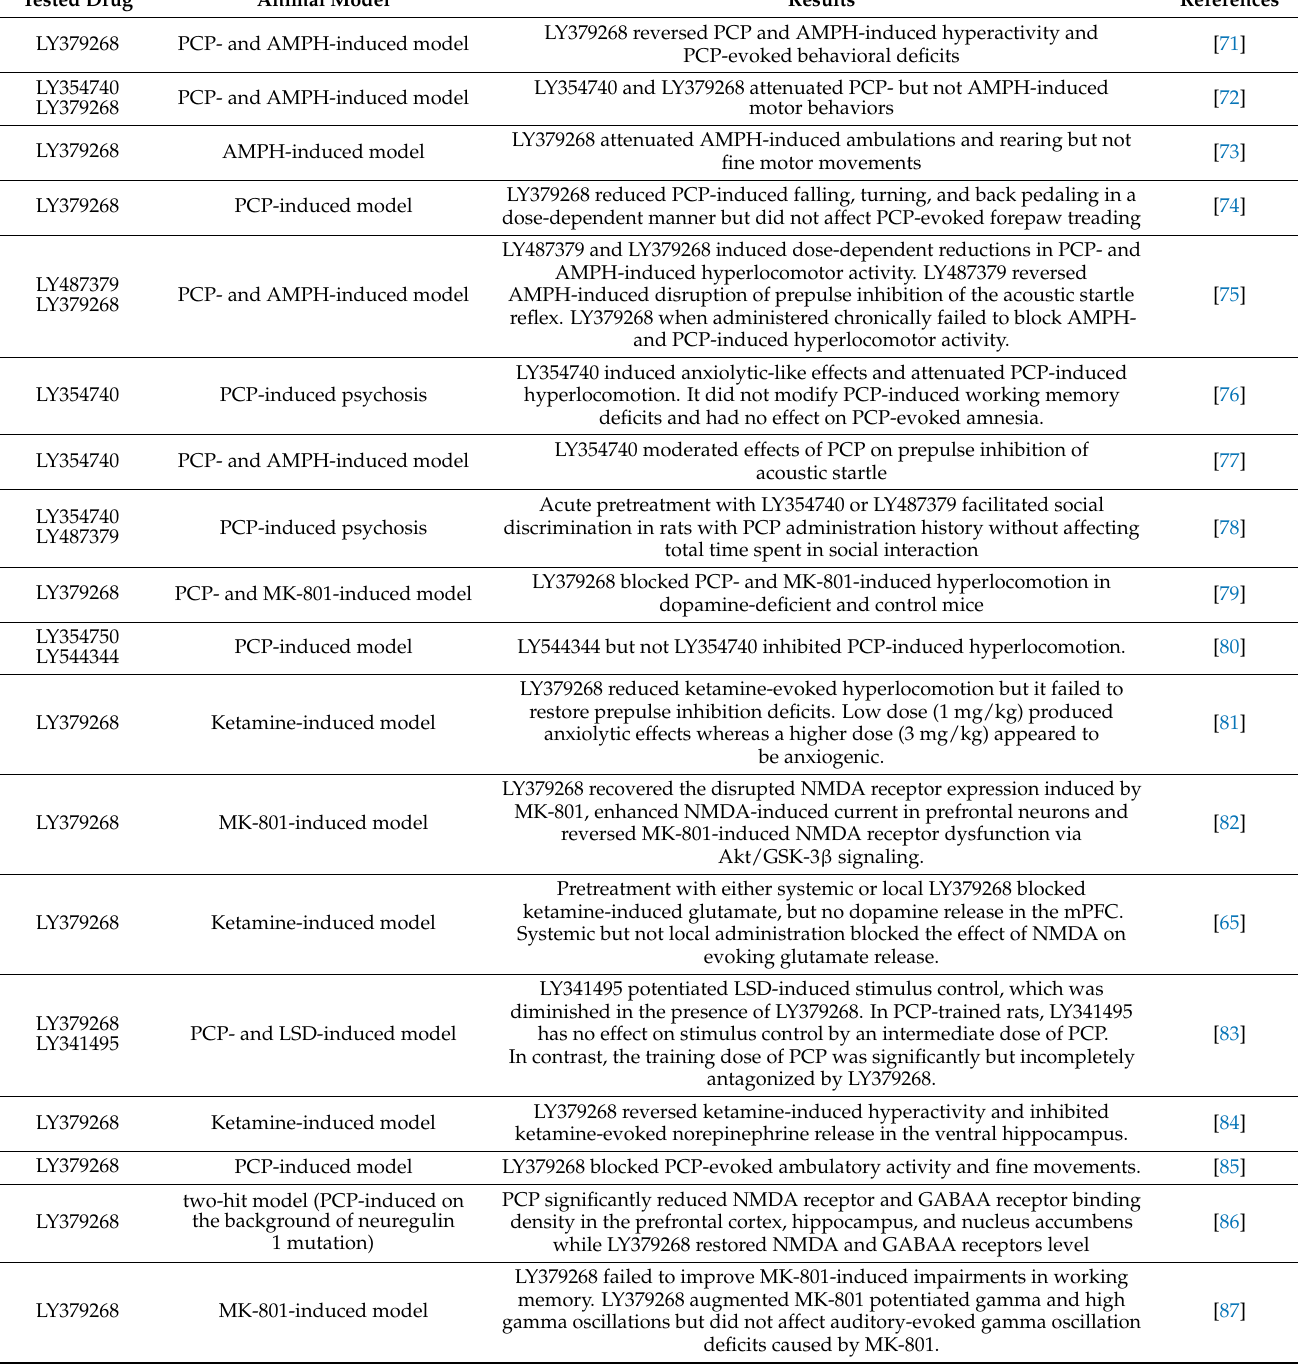
Table 3. Summary of the preclinical studies on mGluR2/3